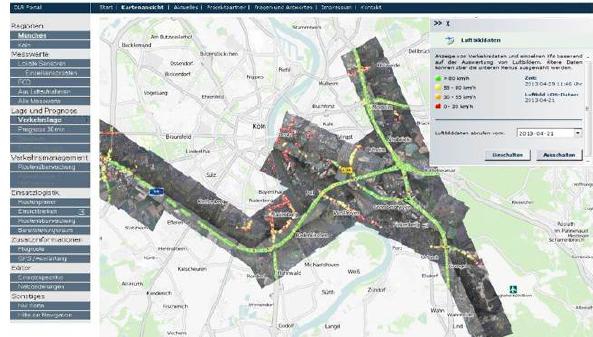
Figure 7: Visualisation of aerial imagery and traffic data using the EmerT web portal End users have appreciated the various possibilities to visualise